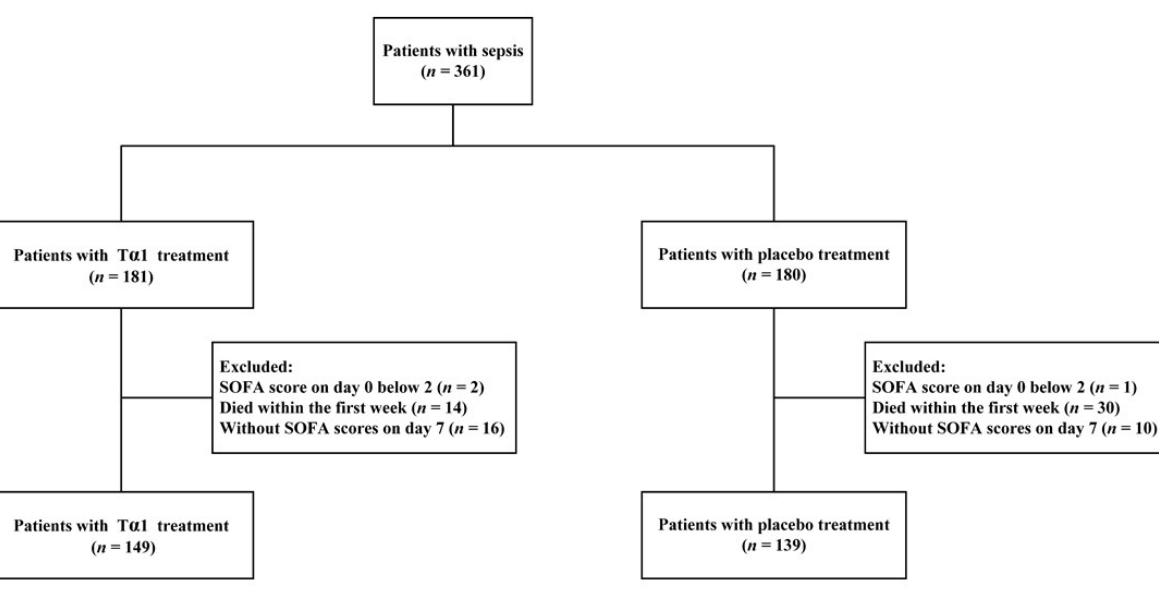
Figure 1. Flow chart of patients with